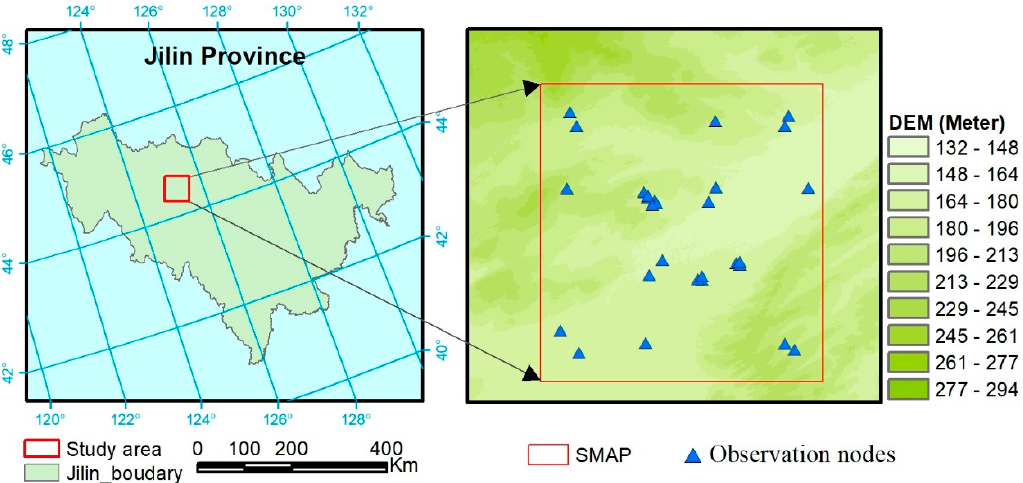
Figure 1. Location of the study area and field soil moisture observation nodes.